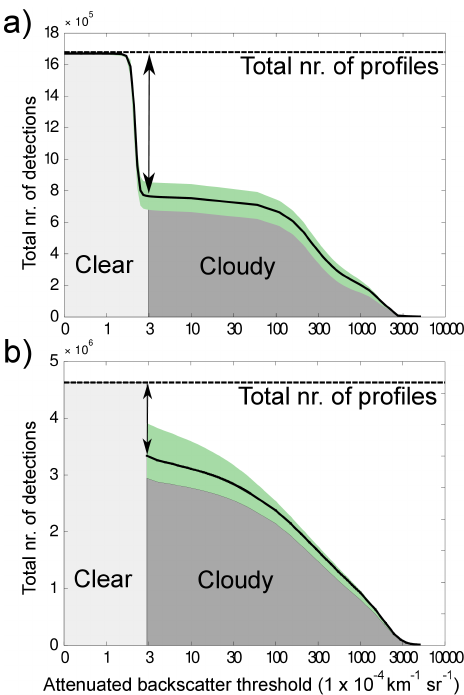
Fig. 6. Sensitivity analyses of backscatter threshold on the cloud detections for (a) PE and (b) Summit. The dashed line indicates the total amount of profiles that have been tested. The arrows show the amount of profiles marked as clear sky using the chosen threshold. The light grey area represents pixels reported as clear by the PT algorithm, while the dark grey area represents pixels reported as cloudy. The green areas represent uncertainty due to SNR-threshold